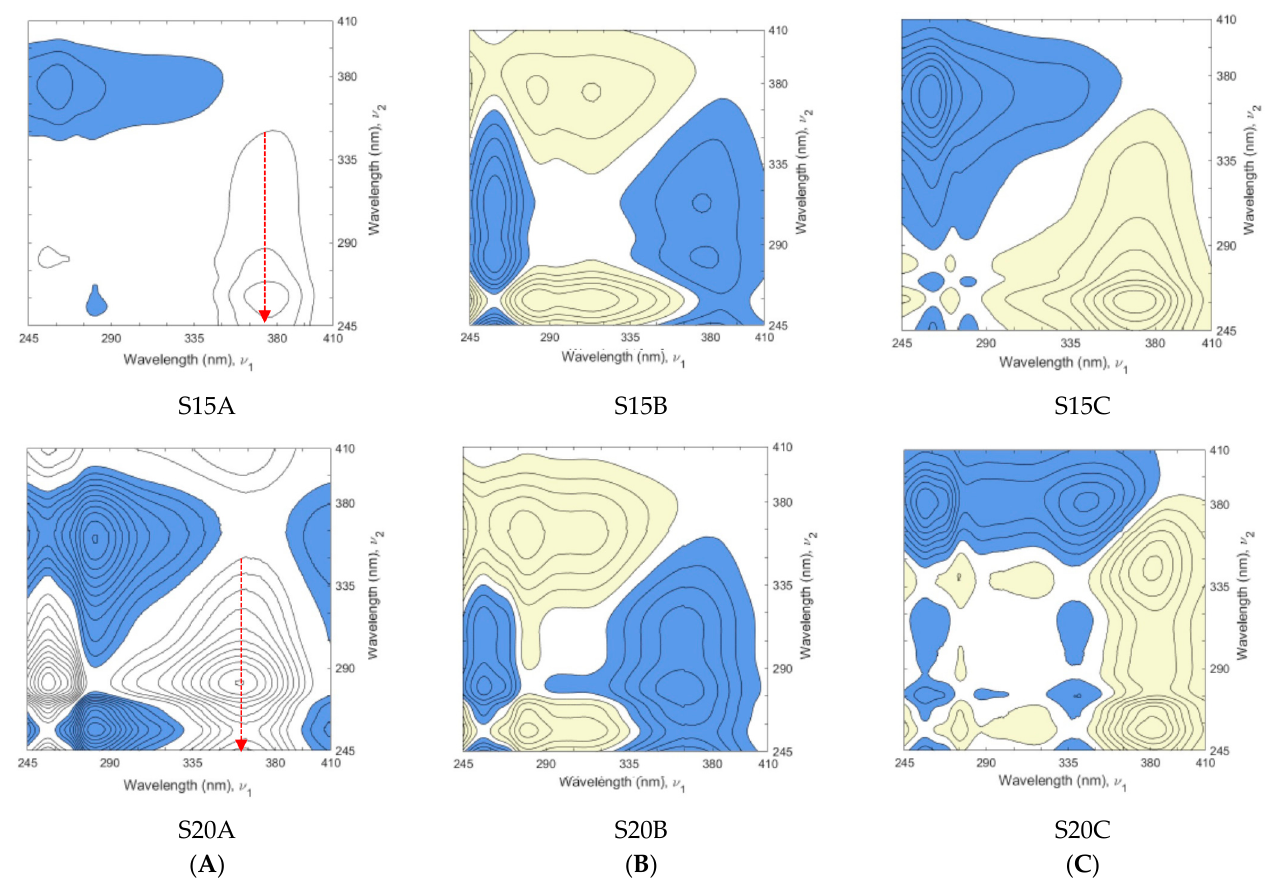
Figure 4. Representative asynchronous 2T2D correlation spectra: ( A ) spectra of 80% methanol extract vs. water extract, ( B ) spectra of food supplements vs. spectrum of ginkgo RM, and ( C ) spectra of food supplements vs. averaged spectrum of adulterants: kaempferol, quercetin, and rutin.